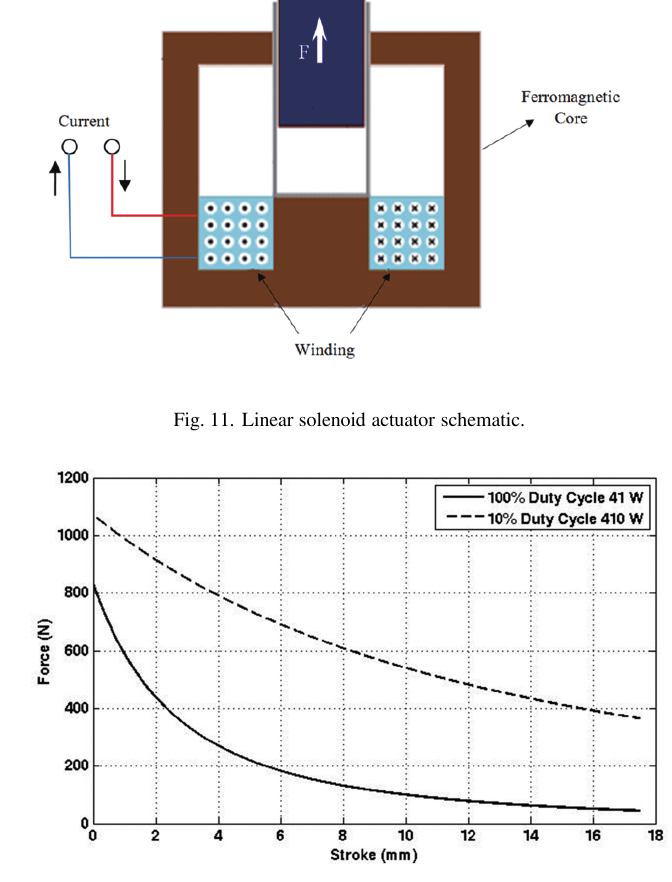
Fig. 12. Force-stroke diagram for a commercial linear